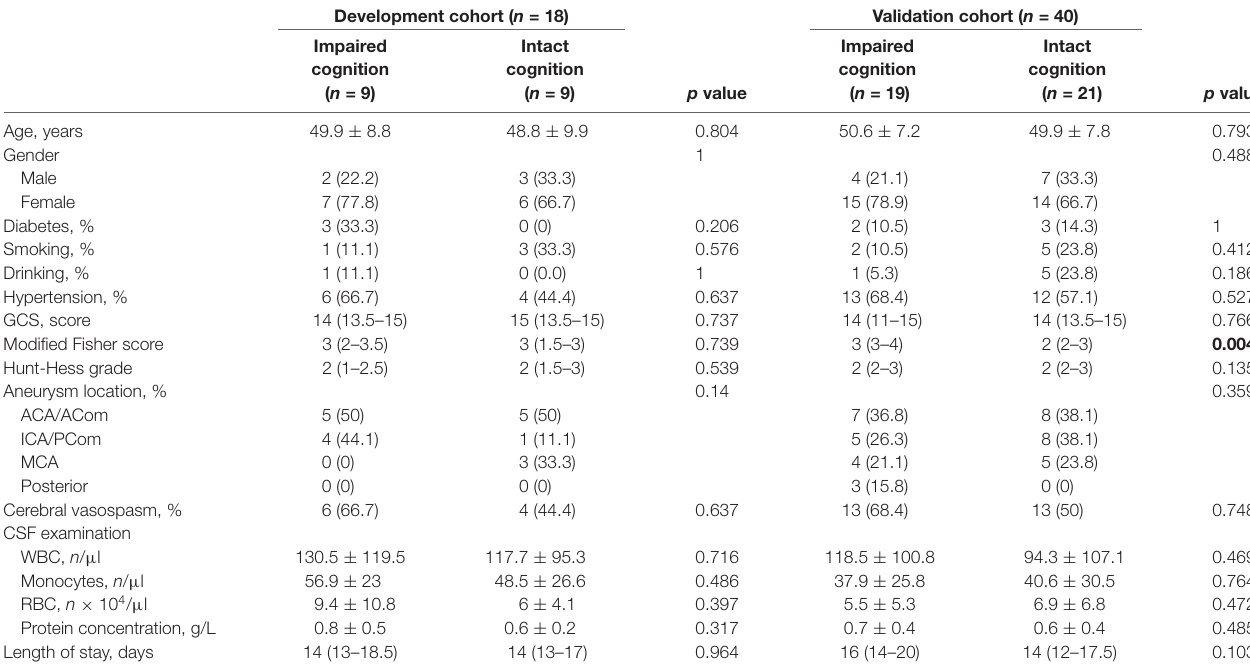
TABLE 1 | Baseline characteristics of the patients with aneurysmal subarachnoid hemorrhage.